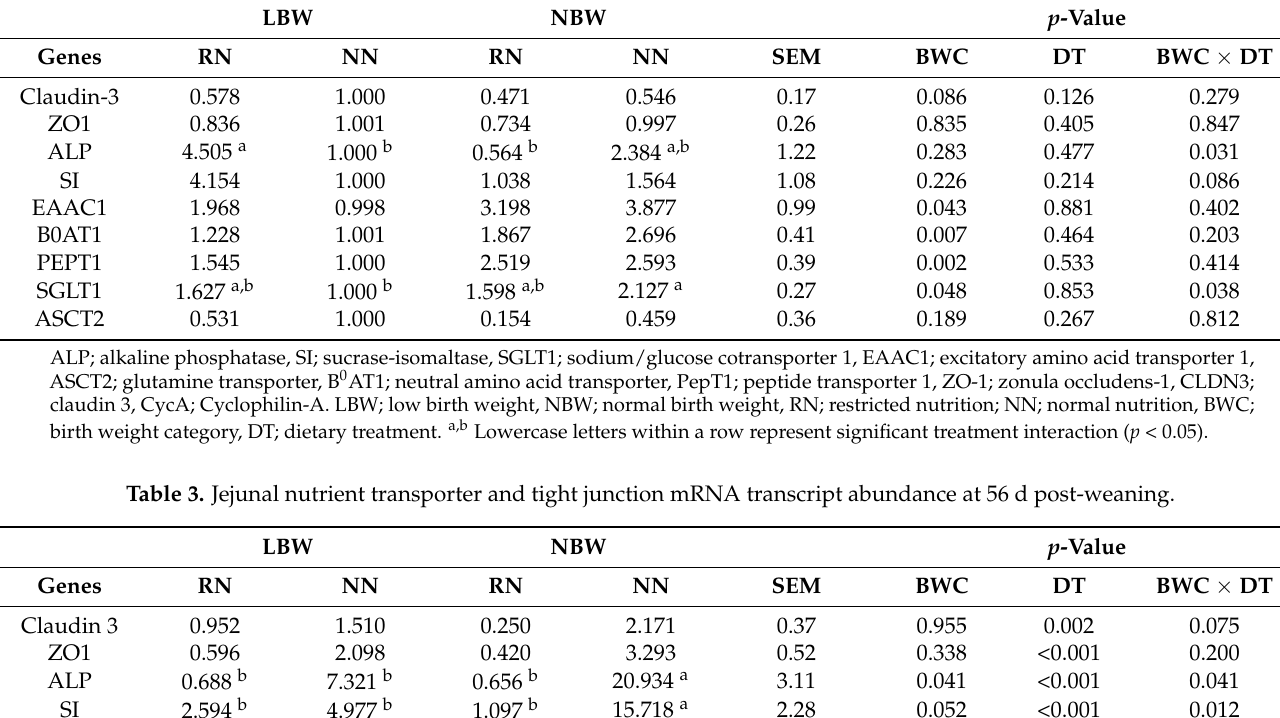
Table 2. Jejunal nutrient transporter and tight junction mRNA transcript abundance at 28 d post-weaning. LBW NBW p -Value